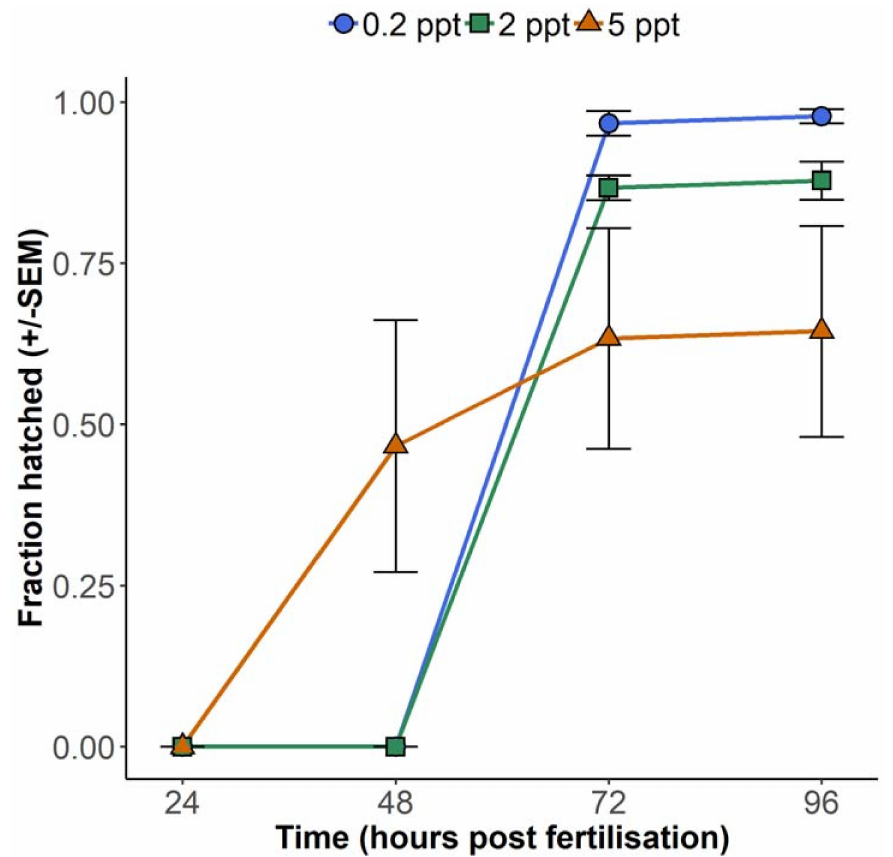
Figure 2. Proportion of zebrafish embryos hatched between 24- and 96-h post-fertilisation while exposed to three salt concentrations up to 5 parts per thousand (ppt) in petri dishes at 25 ◦ C, with exposure beginning from <2 hpf. N = 3 dishes of 30 embryos per treatment level, with each point representing the mean of three